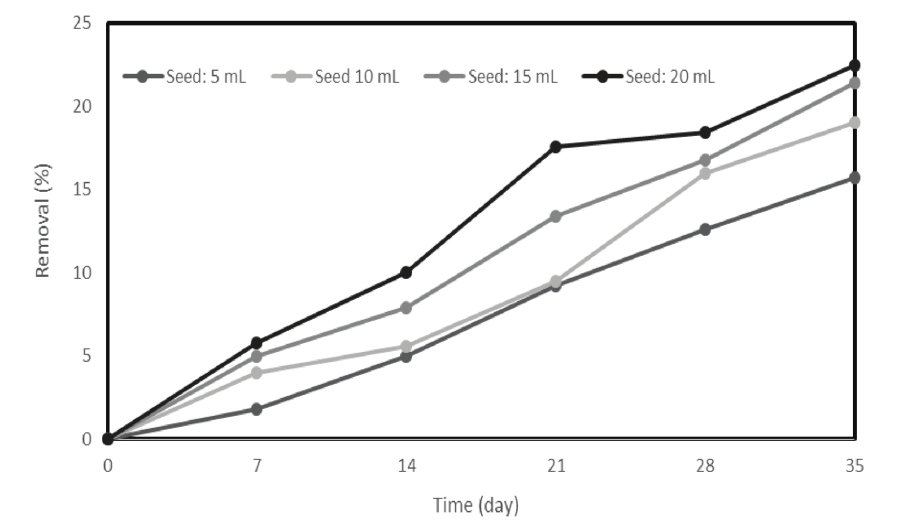
Fig. 2 – Effect of initial inoculums on n-hexadecane biodegradation in synthetically contaminated soil, moisture: 100 %, and salinity: 0.5